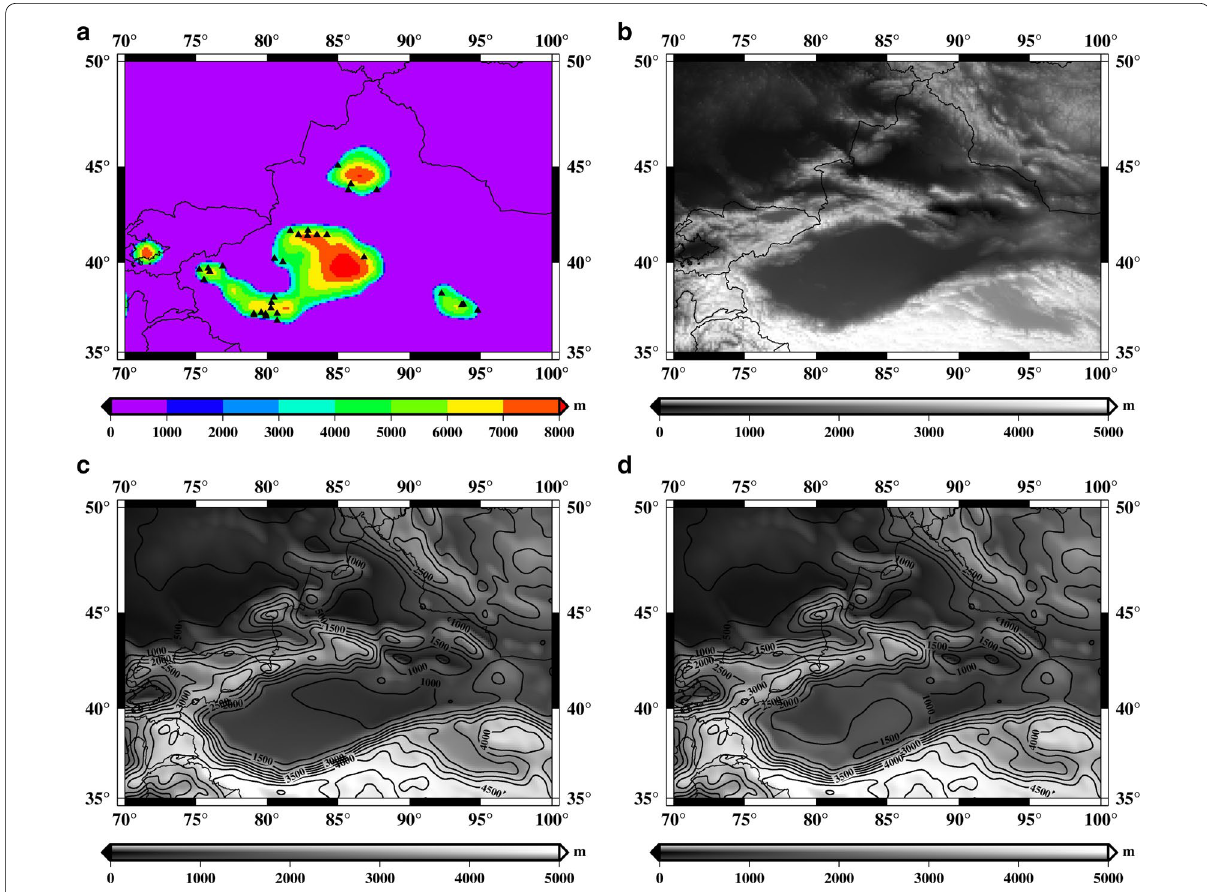
Fig. 7 a Thickness of sediment layer from CRUST 1.0, black triangles are seismic stations, b topography from ETOPO1, c topography after short